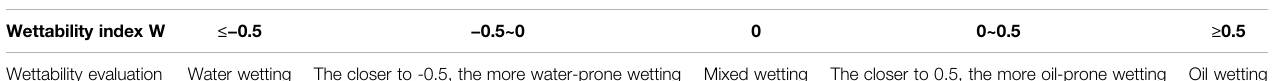
TABLE 6 | Evaluation of rock wettability.